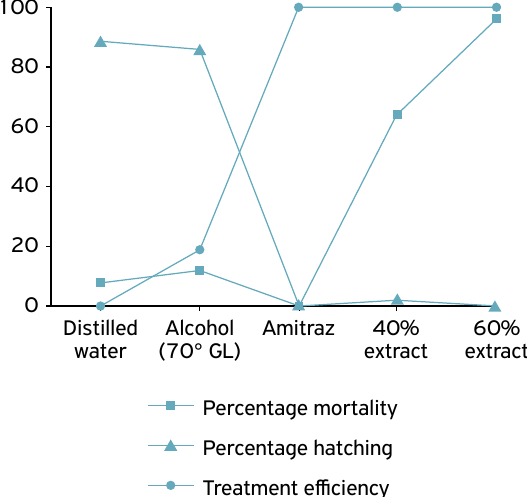
Figure 2. Percentage mortality, percentage hatching and treatment efficiency, relating to in vitro treatments of teleogynes of Rhipicephalus (Boophilus) microplus with distilled water, alcohol (70º), amitraz and 40 and 60% extracts of C. ambrosioides , which were maintained under biochemical oxygen demand (BOD) conditions at a temperature of 27ºC ( ± 1) and 80% relative humidity (